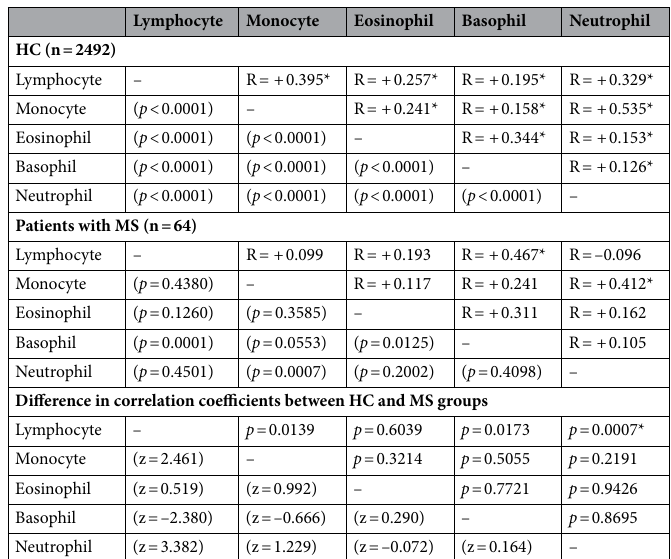
Table 2. Correlation matrix between white blood cell subtypes in patients with MS and healthy controls. Pearson’s correlation coefficients (R) for each pair of white blood cell subtypes in HC and MS patients are shown. At the bottom of the table, statistical differences for each calculated R between the HC and MS groups are listed, together with the calculated Fisher’s z for each pair. HC, healthy control; MS, multiple sclerosis. * p < 0.005.